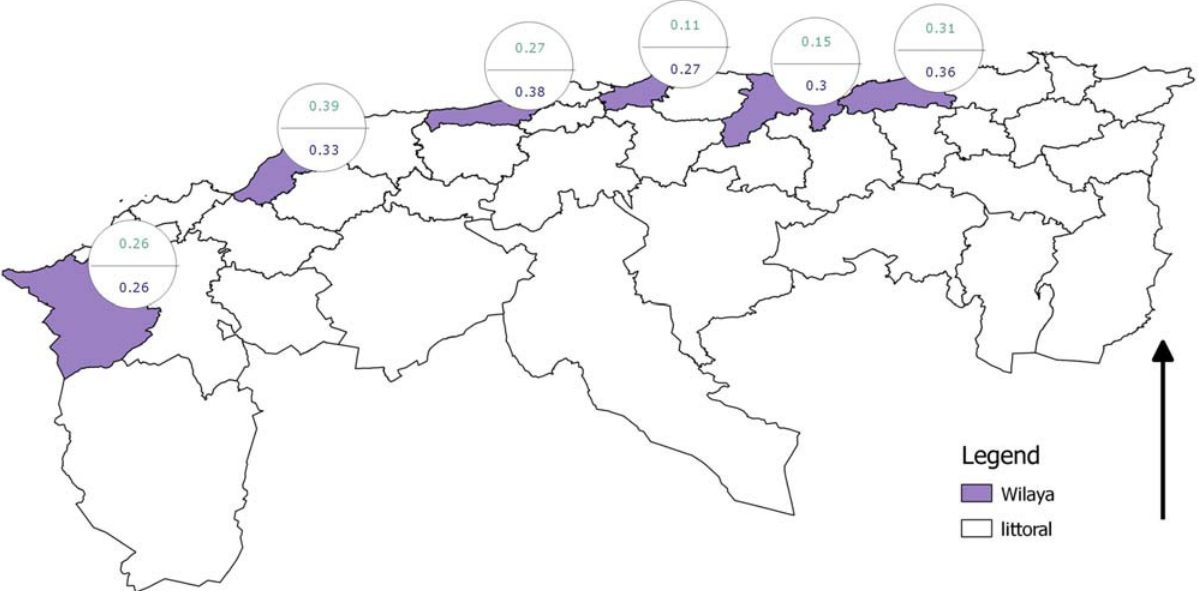
Fig 4. Canine Leishmania infection prevalence estimates according to the Hui-Walter model. Top prevalence is for first sampling period, bottom for second.